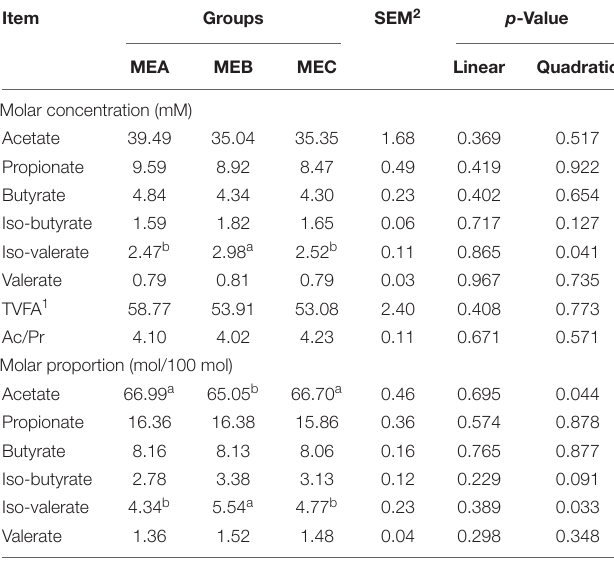
TABLE 2 | Effects of dietary energy levels on rumen fermentation